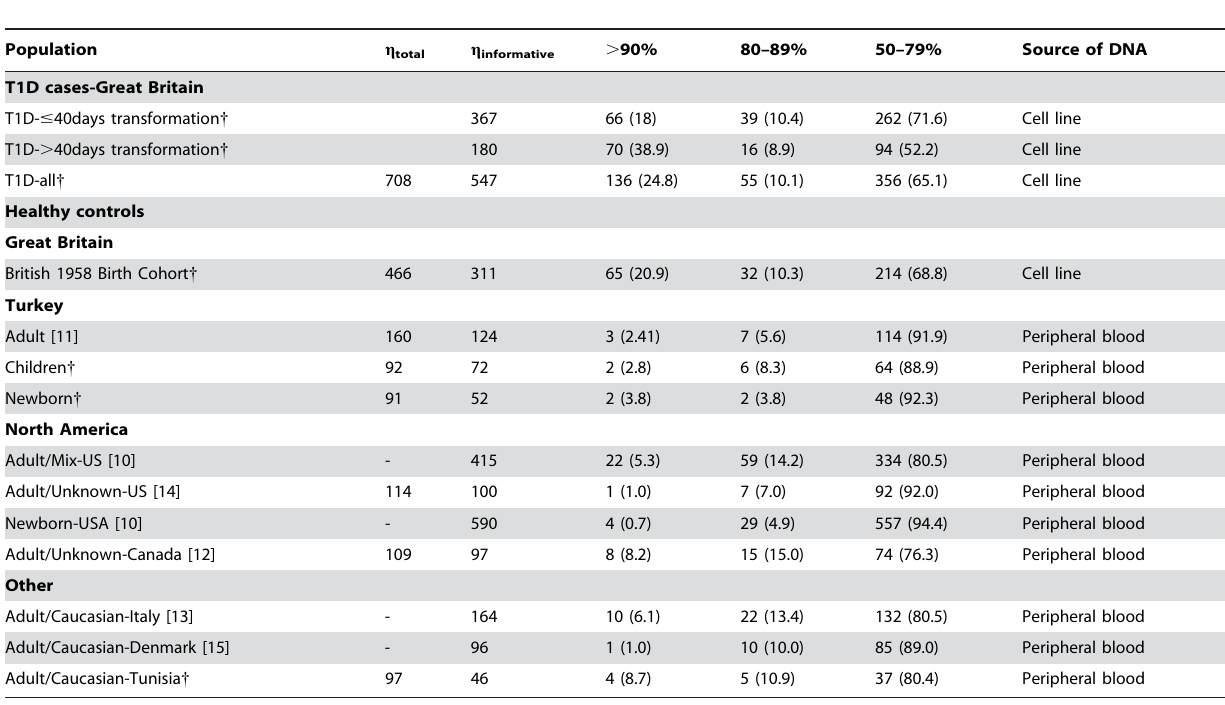
Table 1. Levels of X chromosome inactivation skewing in different groups of healthy and diseased individuals.